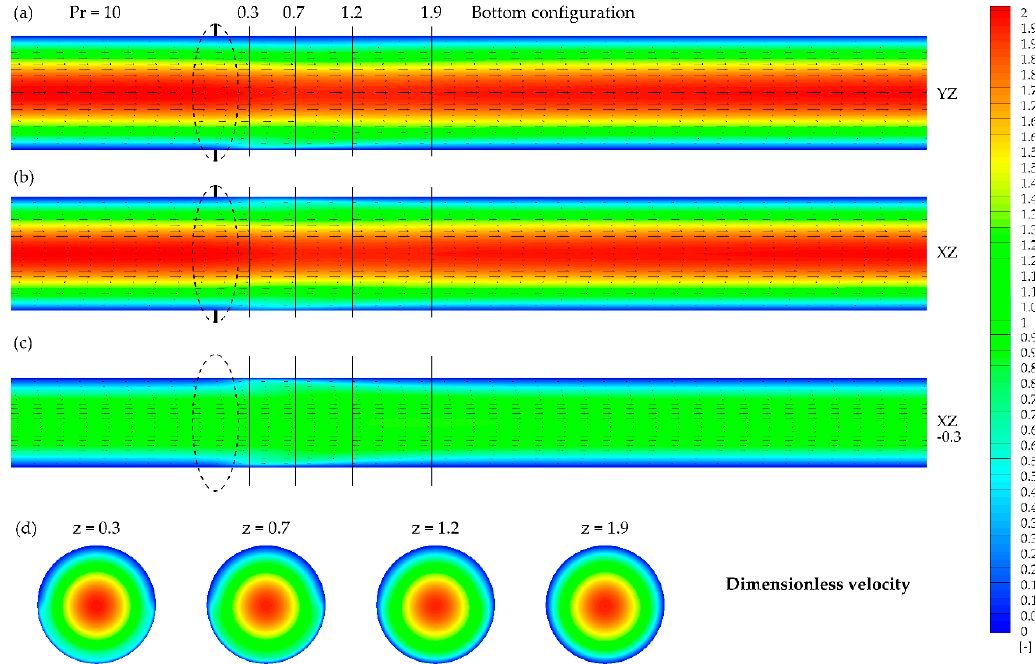
Figure 7. Dimensionless velocity contours and vectors obtained for Pr = 10 and bottom configuration in the presence of the magnetic field at: ( a ) YZ plane, ( b ) XZ plane, ( c ) XZ plane ( y = − 0.3), ( d ) XY planes at given z .